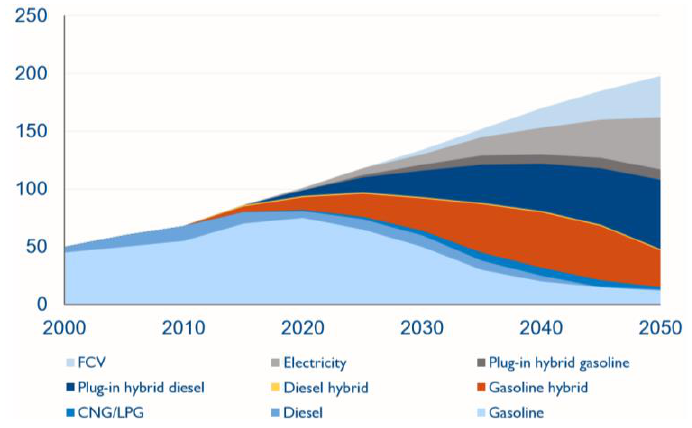
Figure 4. Fuel cell vehicle (FCV) sales volume. Source: IEA. All rights reserved. [59].